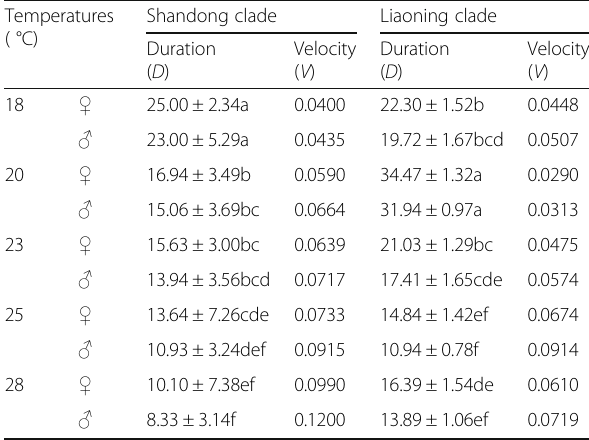
Table 2 Longevity of adults of the non-overwintering generation of Aphelinus mali for two genetic clades in